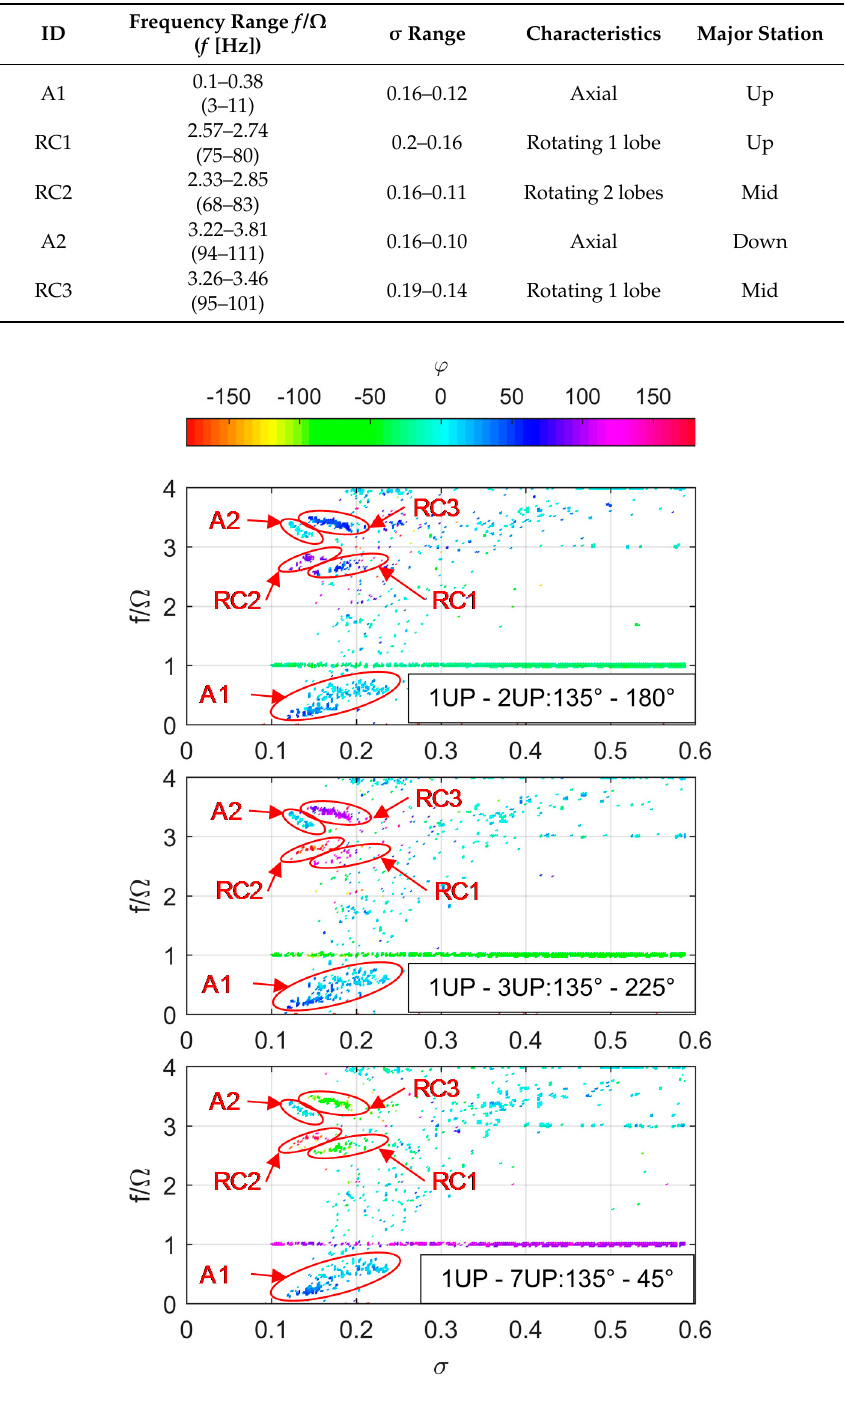
Figure 10. Cross-spectrum phase ( ϕ ) of the upstream pressure transducers, Φ = 0.108 (90% Φ D ). Red circled phenomena are summarized in Table